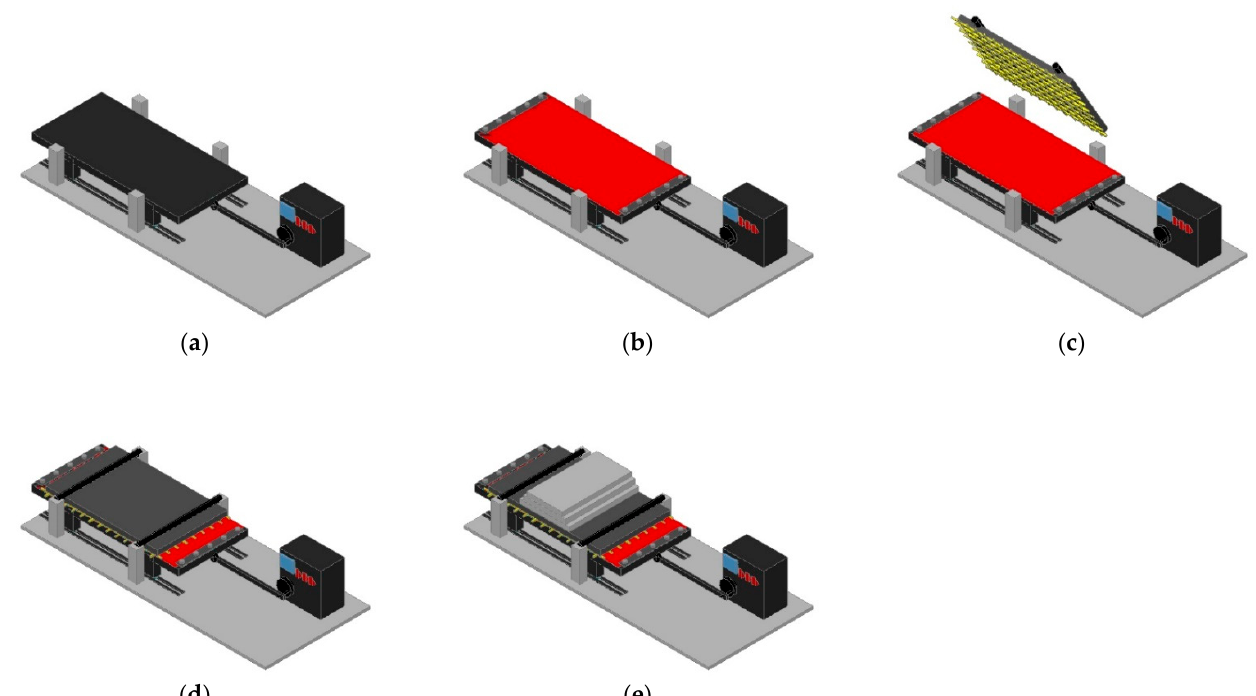
Figure 4. Abrasion test assembly sequence: ( a ) sliding table; ( b ) attachment of the sheet of abrasive (in red); ( c ) geogrid specimen (in yellow) installed in the stationary platform; ( d ) placement of the stationary platform and ( e ) placement of the metal weight (grey plates).